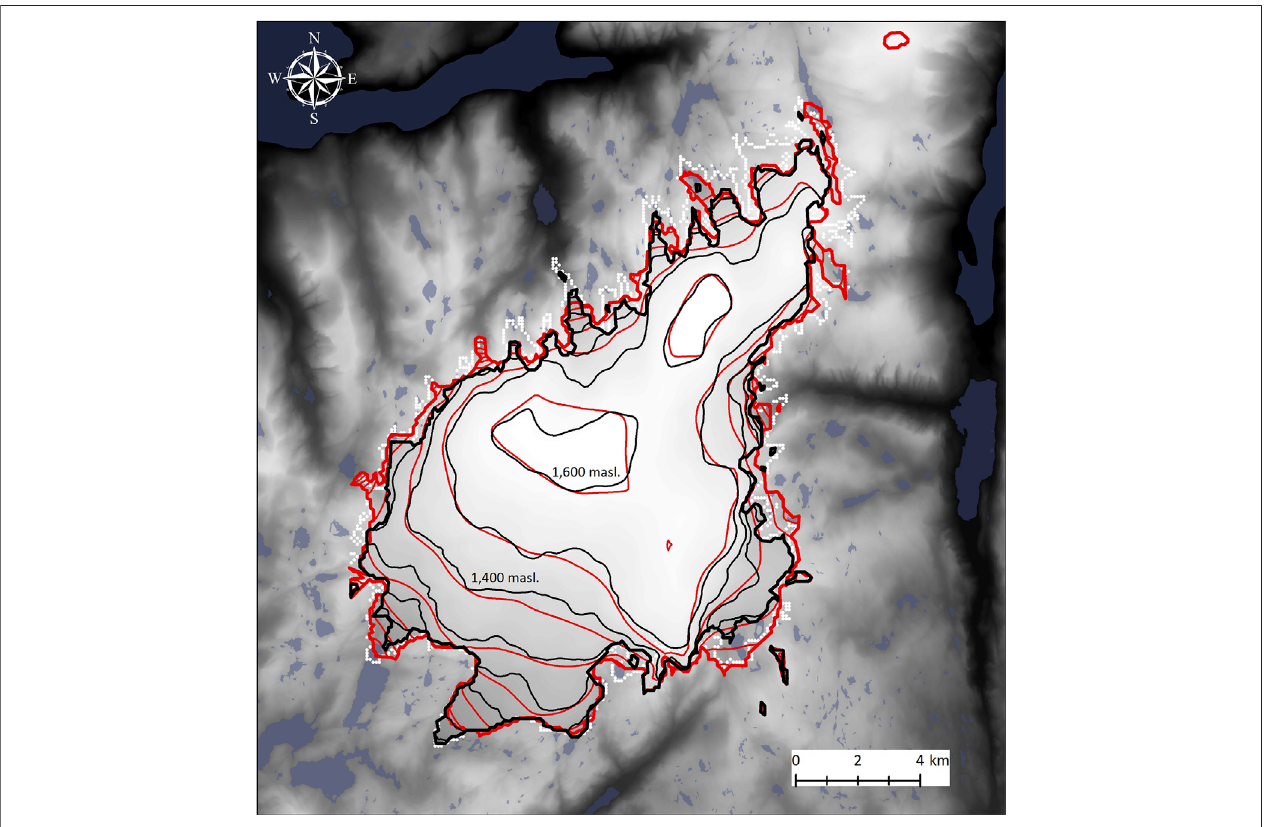
FIGURE4| ExtentofSørfonnameasured in2013(black)andmodelledextent (red),withthemeasured glacierextentof1959usedastheinitialinputforthemodel. Area differs 16 km 2 and, perimeter 6 km, between the two. The white dotted line is the measured extent of the ice cap 1959. The resolution of these extents is 100 m.